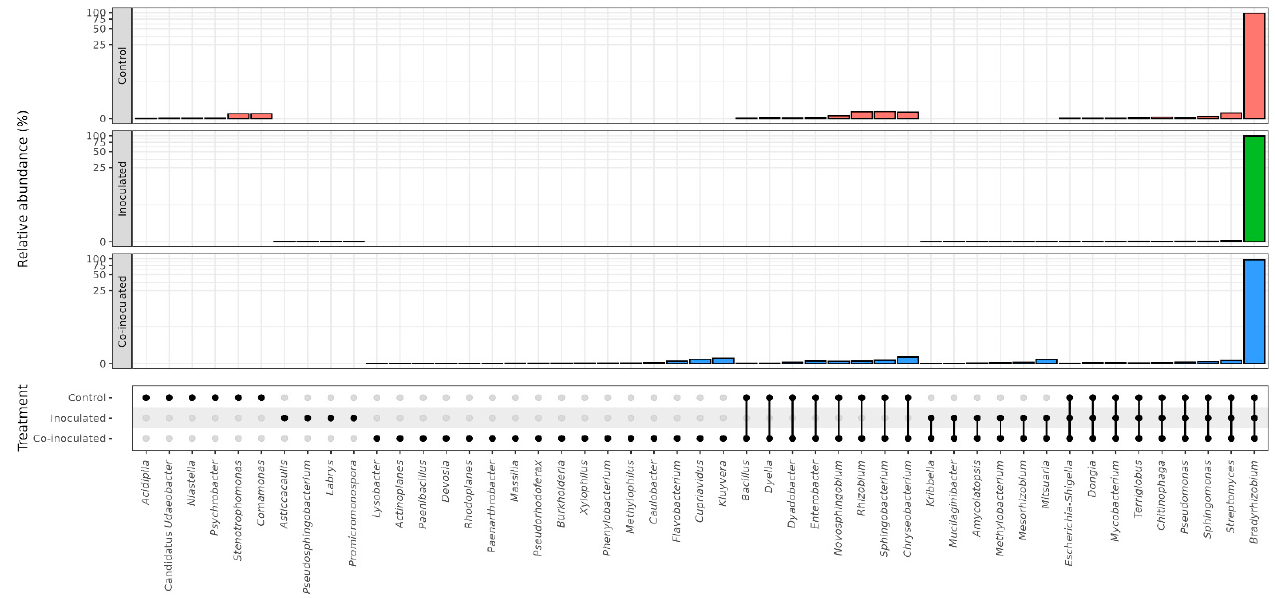
Figure 3. Genera of bacteria in the microbiomes of soybean nodules in the treatments (i) non-inoculated (control); (ii) inoculated with Bradyrhizobium spp.; and (iii) co-inoculated with Bradyrhizobium spp. and Azospirillum brasilense .